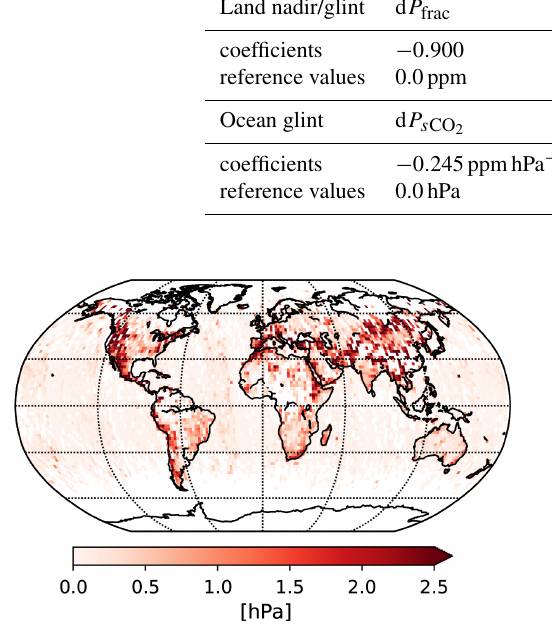
Figure 9. Difference between v9 and v8 (v9–v8) of the surface pres- sure prior standard deviation in each grid cell for April 2016. Data are aggregated into 2 ◦ × 2 ◦ latitude–longitude square